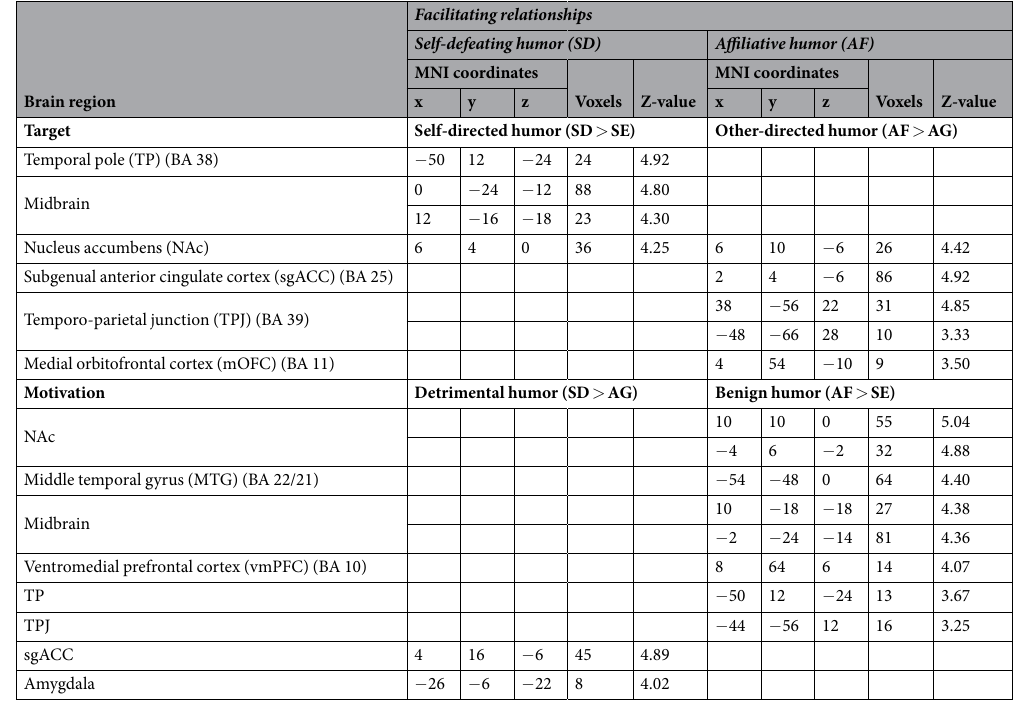
Table 2. Activation levels of ROIs in the brain showing simple main effects during humor appreciation. Note: MNI coordinates of peaks of relative activation within ROI regions activated by simple main effects of self- directed humor, other-directed humor, detrimental humor, and benign humor. The activation threshold was set to p < 0.05 FWE (familywise error rate) corrected at the peak level, and clusters greater than or equal to 8 are presented. SD = self-defeating humor; SE = self-enhancing humor; AF = affiliative humor; AG = aggressive